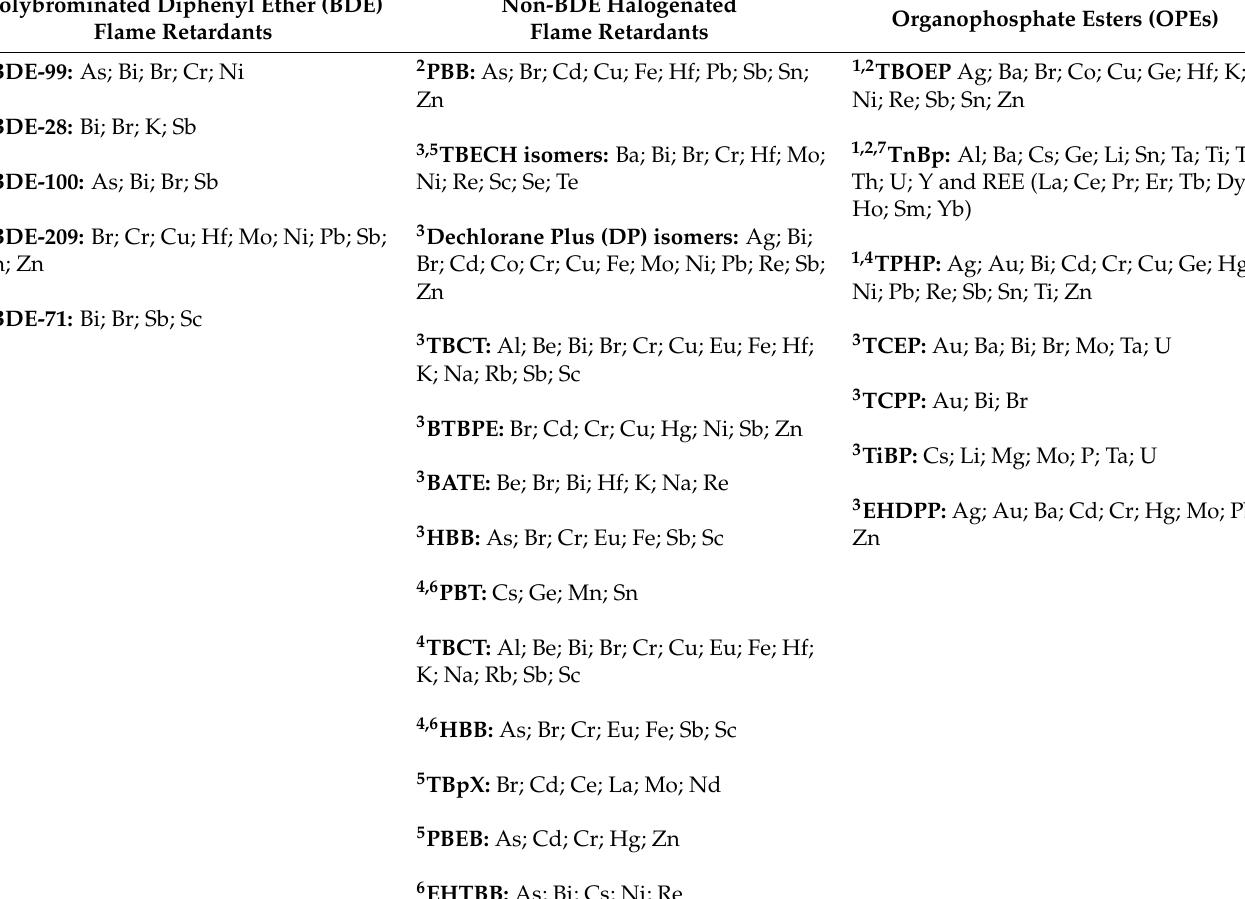
Table 6. Metal(loid)s associated with organic compounds ( p < 0.05) that correlate with common flooring or heating characteristics in CHDS homes. Superscripts indicate which characteristics are significantly associated ( p < 0.05) with that organic compound: 1 = %hardwood, 2 = %vinyl, 3 =